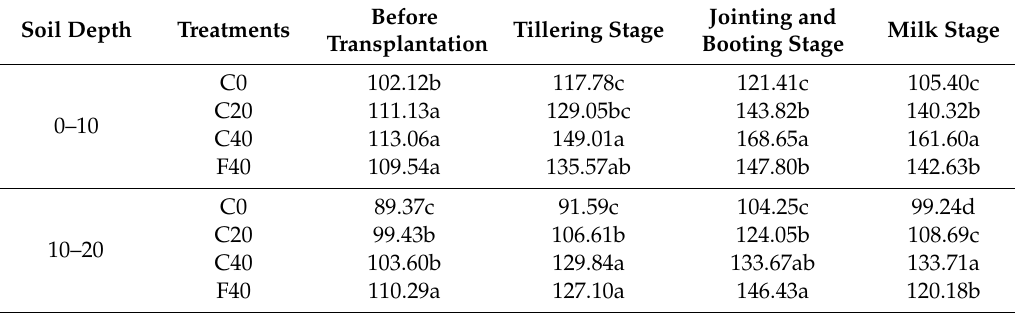
Table 3. Characteristics of soil microbial biomass carbon (SMBC) under di ff erent water-carbon regulation scenarios in paddy fields (mg /